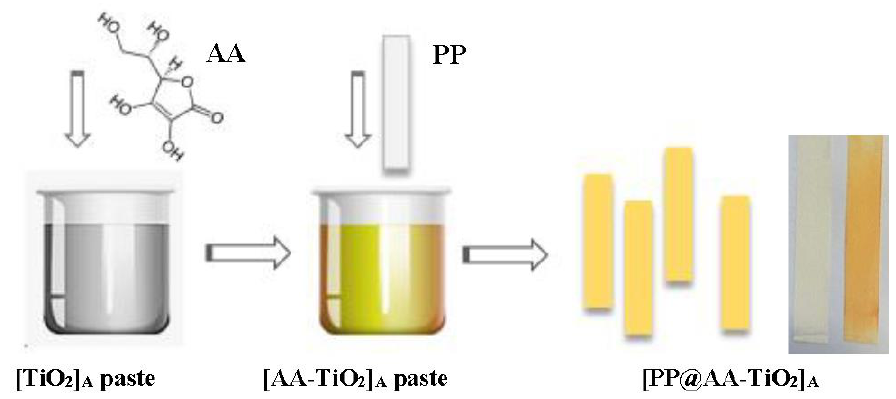
Figure 1. Schematic representation of the operative steps for the preparation of the new modified heterogeneous [PP@AA-TiO 2 ] A photocatalyst and photograph of [PP@AA-TiO 2 ] A prepared with two different AA amount wt %.